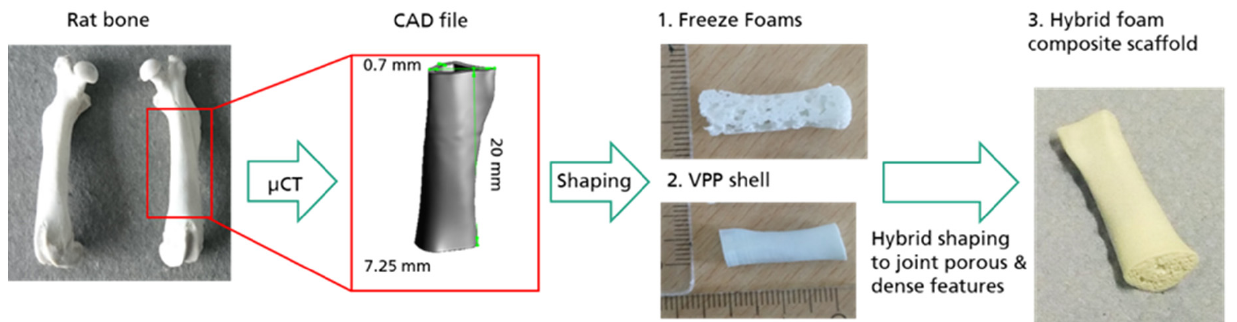
Figure 3. Reverse-engineering workflow from rat bone to a CAD file to the manufactured Freeze Foams and hybrid foams (artificial corticalis case).